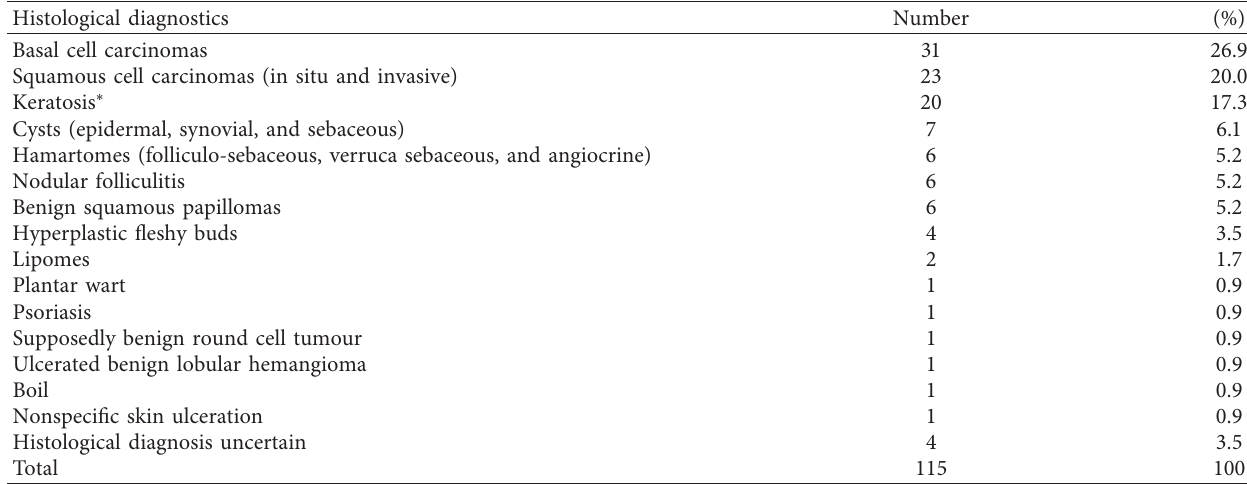
Table 1: Histological diagnosis in PWA in Togo in